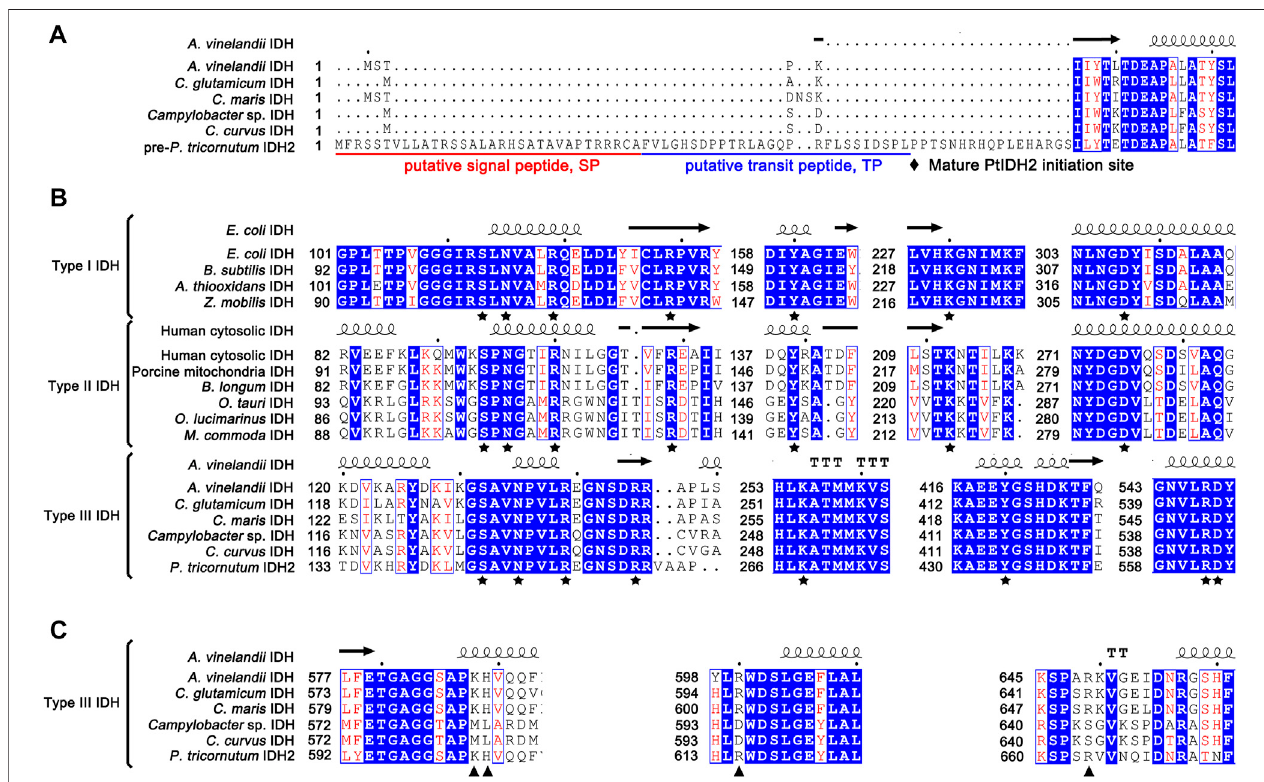
FIGURE 2 | Structure-based protein sequence alignment of PtIDH2 with other isocitrate dehydrogenases (IDHs). (A) Comparison of the N-terminal amino acid sequenceofPtIDH2withthoseofotherbacterialmonomericIDHs.Theputativesignalpeptideandtargetpeptidesequencesareunderlinedinredandblueandpossible cleavage sitesareindicatedbyarrows. (B) Theconserved substrate-binding aminoacidresiduesoftheIDHprotein family areindicatedbypentagrams. (C) Theputative conserved residues implicated in PtIDH2 coenzyme binding are compared with those of other monomeric NAD(P)-IDHs. The residues that directly or indirectly interact with the 2 ′ -phosphate of NADP + are indicated by